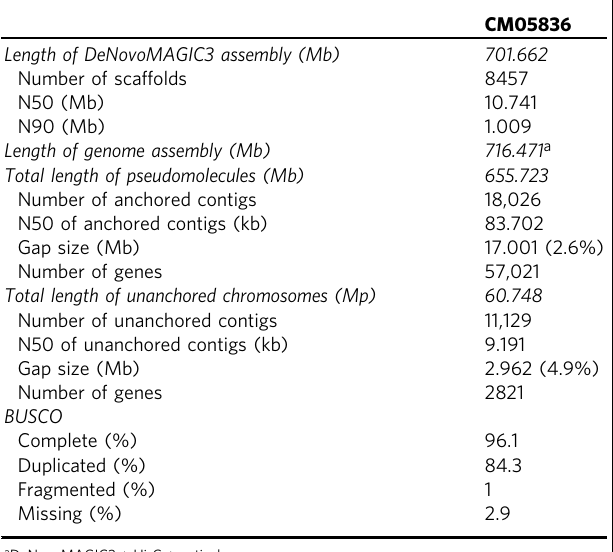
Table 1 Statistics of the fonio genome assembly and